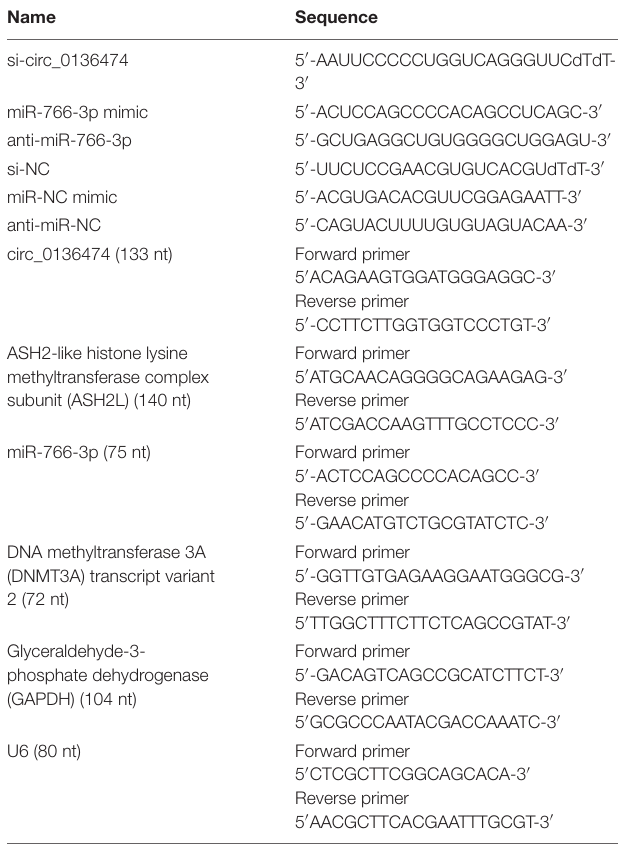
TABLE 2 | The sequences of oligonucleotides and primers.